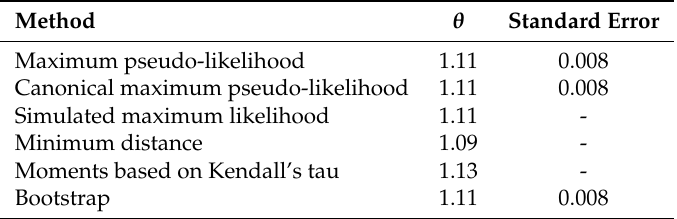
Table 10. Different methods for estimating the dependence parameter θ of a Gumbel Copula.